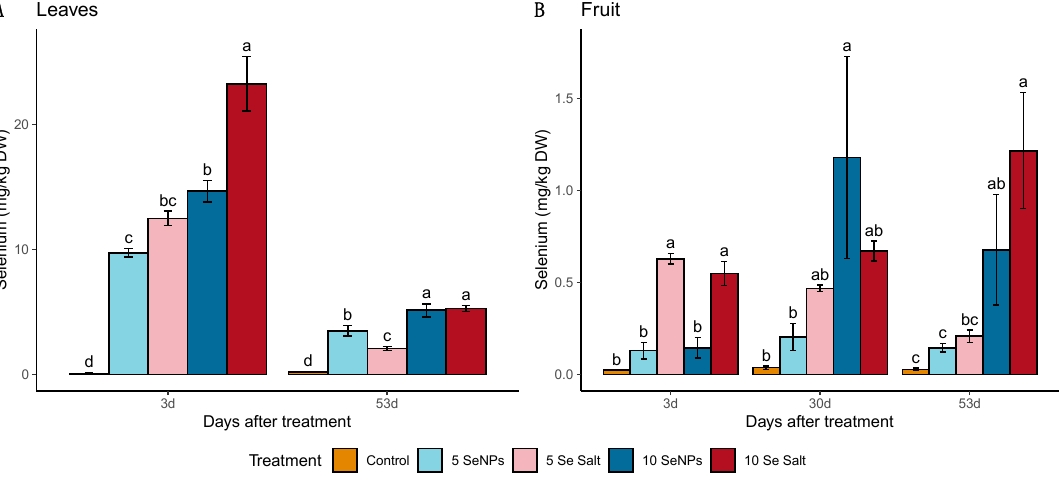
Figure 3. Total Se content in tomato leaves ( A ) and fruit ( B ) (cv. Micro-Tom) 3, 30, and 53 DAT at 0, 5, and 10 mg Se L − 1 as Se nanoparticles (NPs) and sodium selenate (Se Salt). Bars indicate standard error. Letters indicate the results of the LSD test run separately for each date. Values with the same letter are not statistically different ( p ≤ 0.05; n = 4).